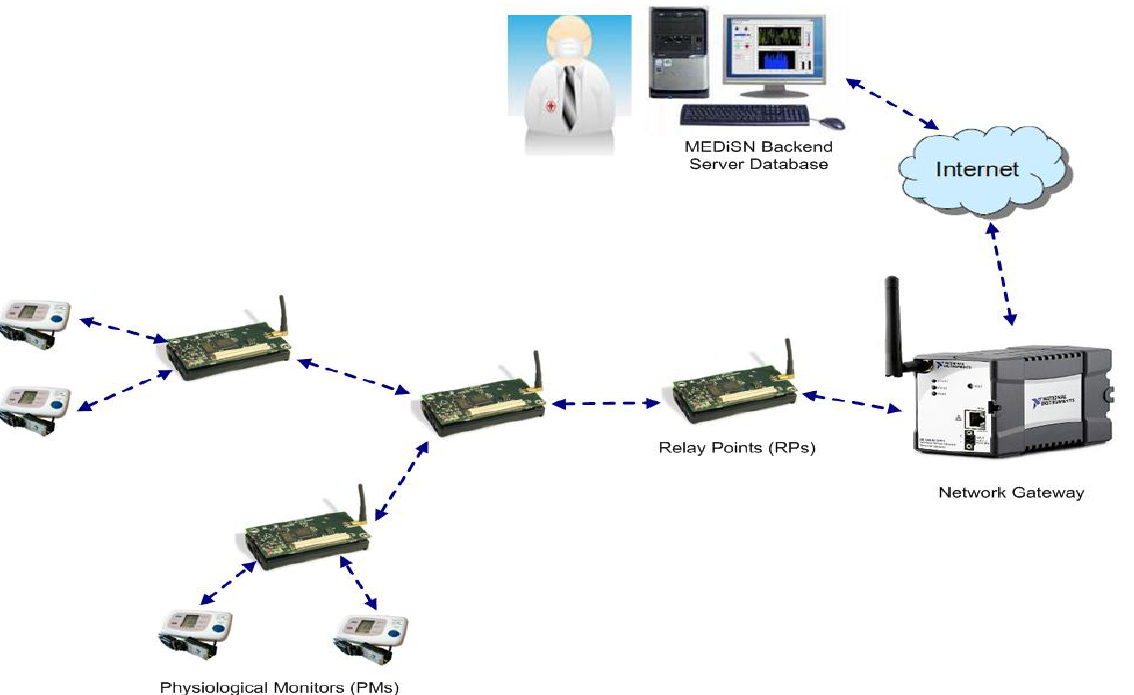
Figure 2. Overview of MEDiSN architecture and